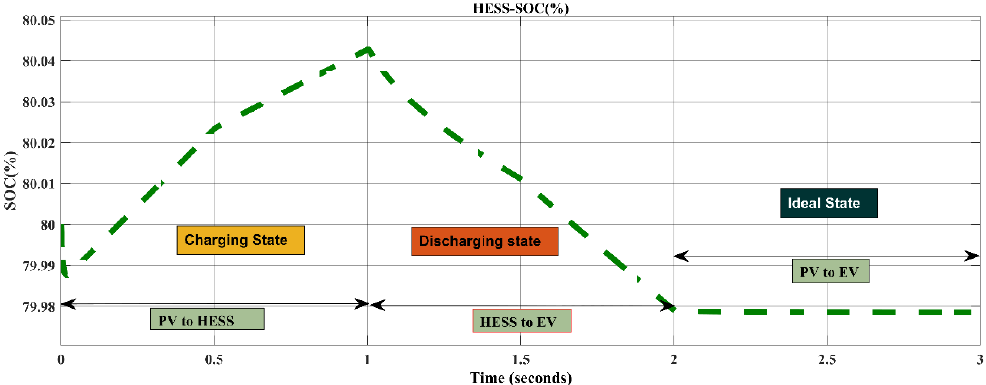
Figure 21. Battery SOC (%) for various modes of operations.